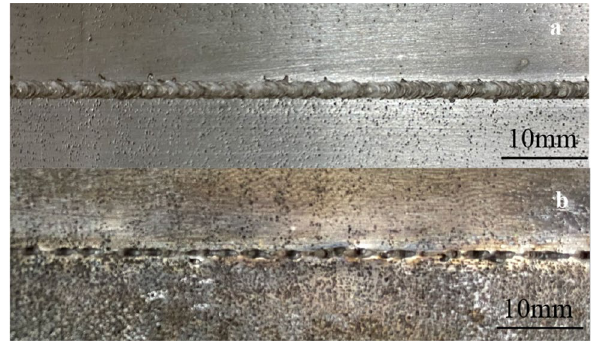
Fig. 2 Appearance of WE43 magnesium alloy EBW joint: a the front, b the back